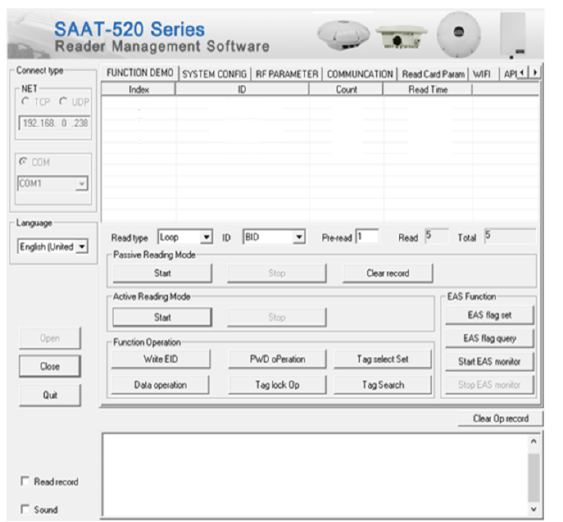
Fig. 3. SAAT-F520 series reader